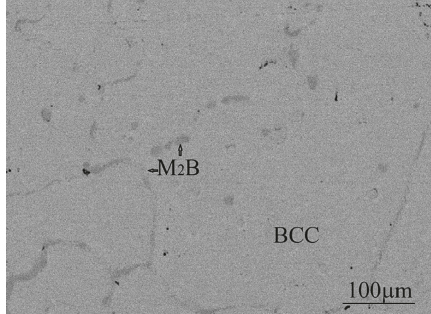
Figure 9: Microstructure of the alloy 3 after annealing.